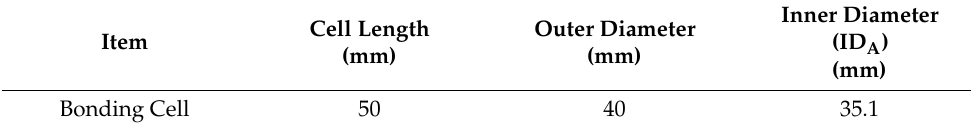
Table 2. Geometries of the shear and bonding cells.